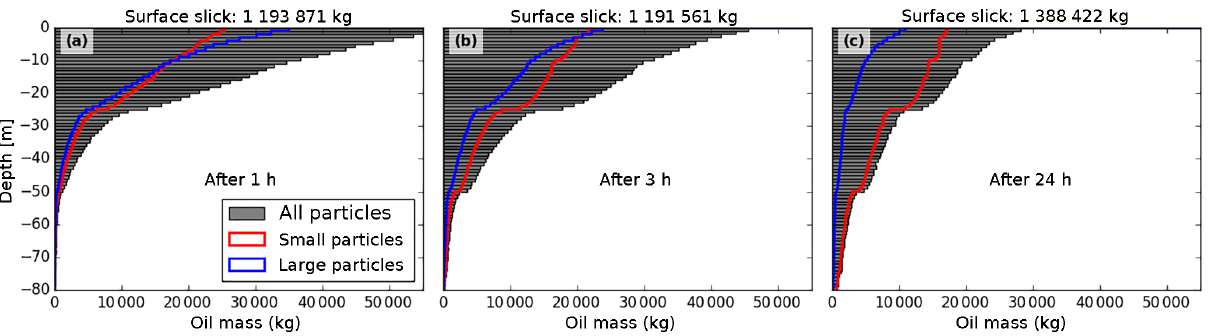
Figure 7. Vertical mass distribution of submerged oil droplets for all particles (shaded gray), small droplets (red), and large droplets (blue). The overall medium droplet diameter from these simulations (160µm) is used as a threshold between small and large droplets. (a) The vertical distribution after 1h, (b) 3h, and (c) 24h. All three oil types are included in these